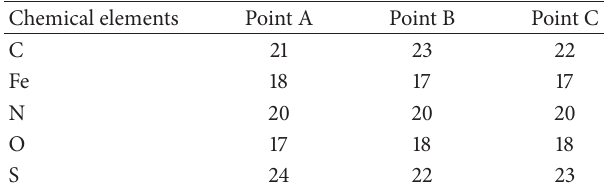
Table 5: Chemical composition (%) of MO formed within SC in industrial plant located in Mexicali as in Figure 4(c)